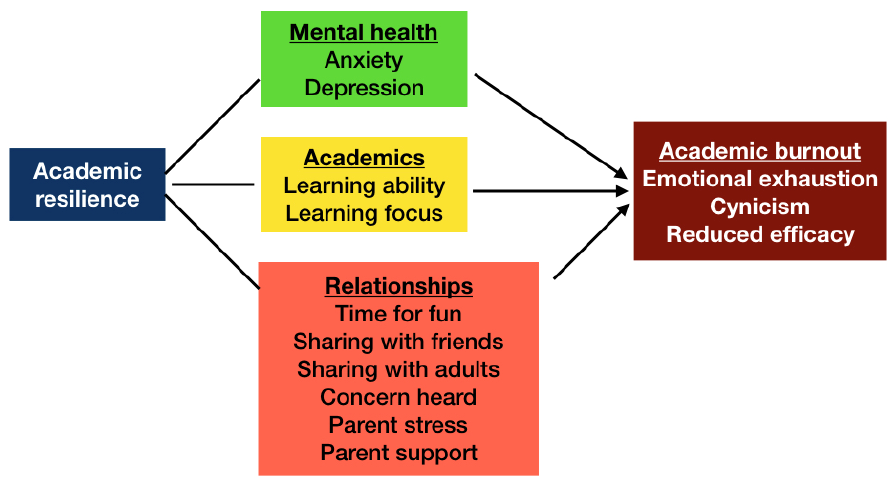
Figure 1. Conceptual framework that hypothesizes a relationship between academic resilience and academic burnout.